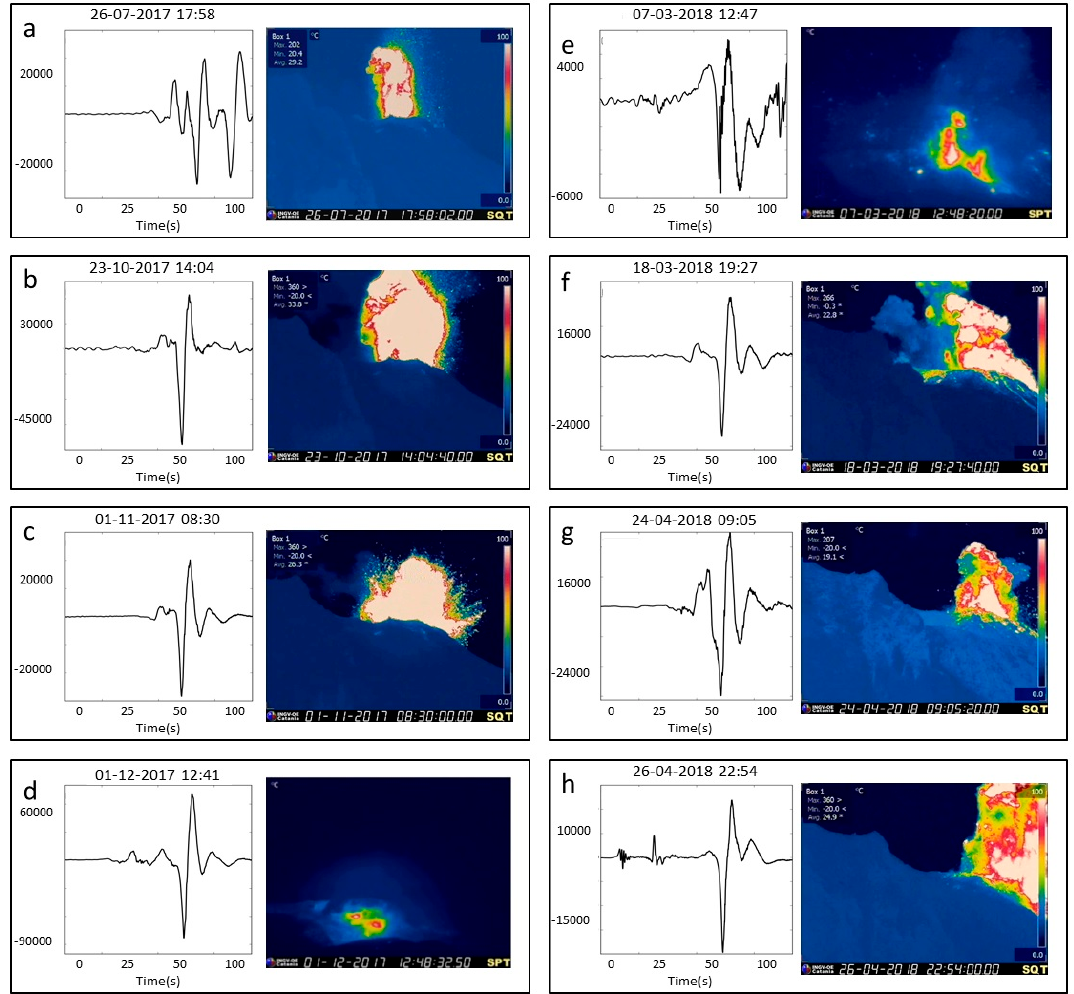
Figure 5. VLP seismograms and thermal images of the major explosions recorded by the thermal camera at 400 m elevation on the NE flank of the SdF ( a – c , f – h ) and by the thermal camera at “Il Pizzo Sopra la Fossa” (890 m a.s.l. and ~250 m from the craters) ( d , e ). The date and time of each episode is plotted in the format dd-mm-yyyy hh:mm at the top of each graph.